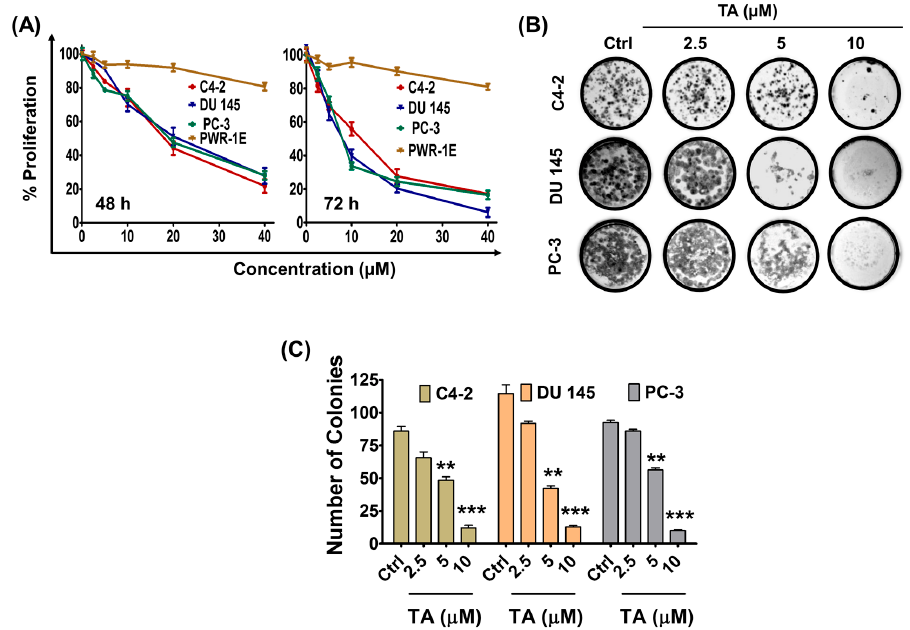
Figure 1. Tannic acid inhibited the growth of prostate cancer cells. ( A ) Effect of Tannic acid (TA) on cell proliferation of human prostatic epithelial cells (PWR1E) and prostate cancer (C4-2, DU 145 and PC-3) cells. Cells (5000) were seeded in each well of 96-well plate and allowed to grow